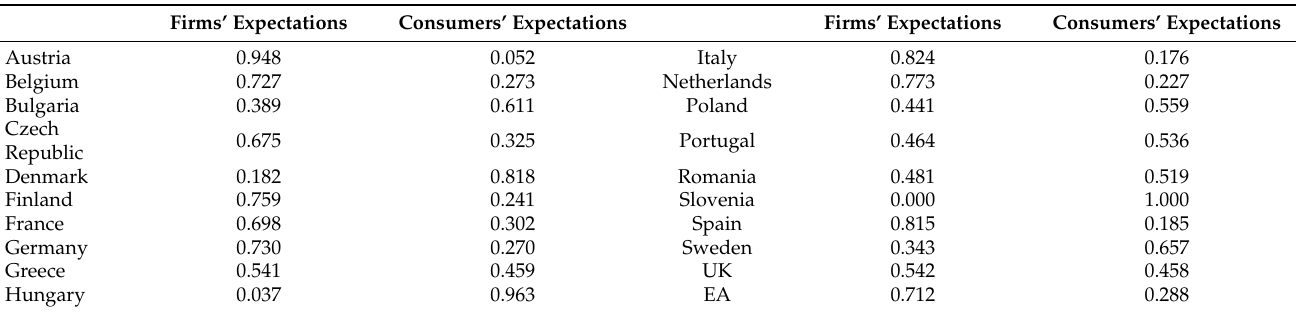
Table A2. Relative weights of evolved